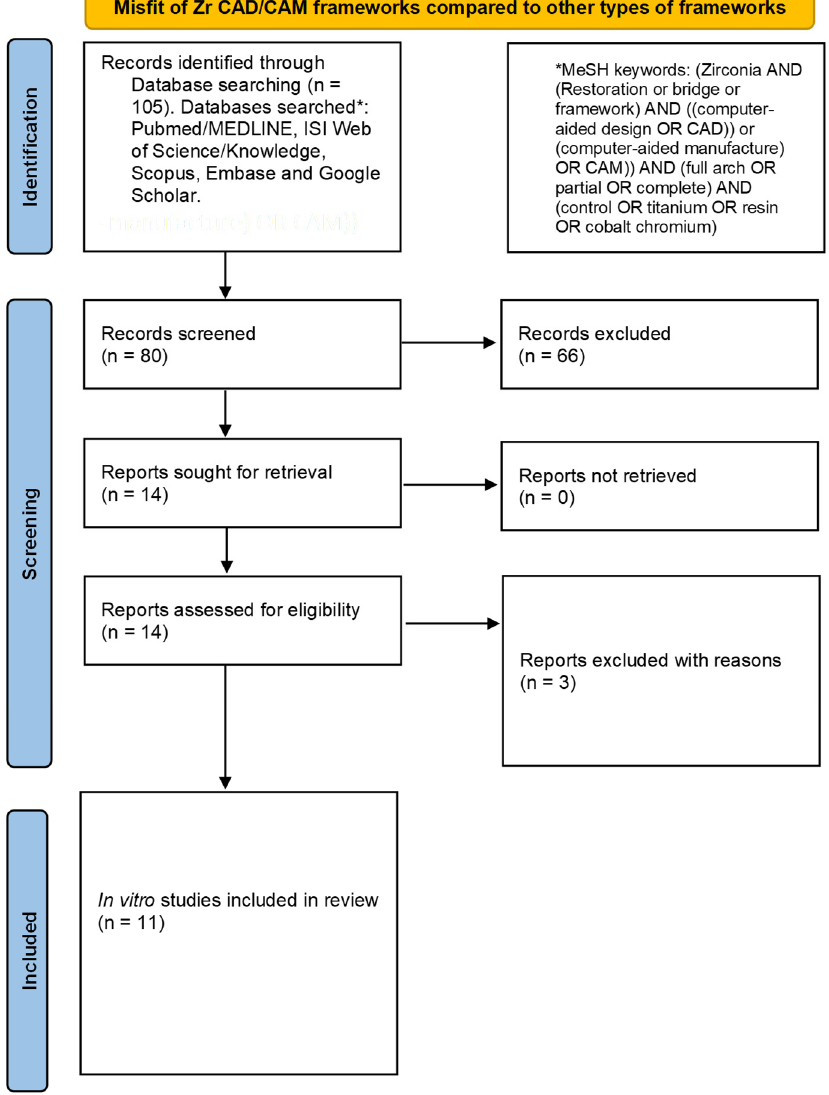
Figure 1. PRISMA flow diagram employed for the literature search.